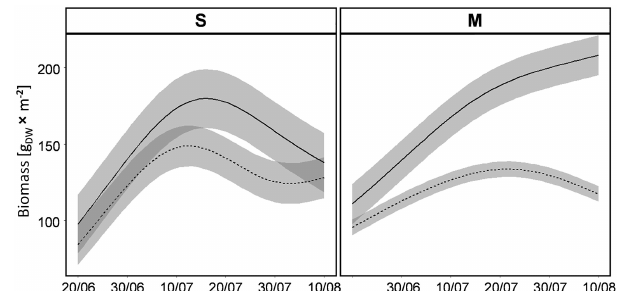
Figure 4. Predictions of biomass development for the two vegeta- tion types (S: Stubai; M: Matsch/Mazia; Table 1) subjected to con- trasting irrigation regimes (REG – solid lines; D – dashed lines; shaded area – standard deviation) throughout the duration of the ex- periment based on nondestructive measurements. Measured values used for these predictions are shown in Supplement Fig.